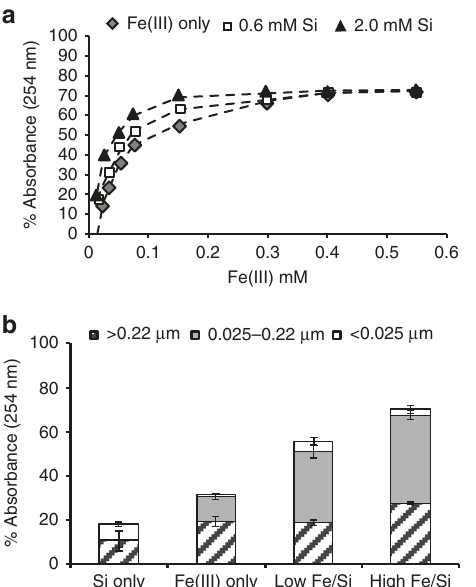
Fig. 4 UV-C attenuation in cell free, Fe(III) – Si-supplemented growth media. a Attenuation (% absorbance at 254 nm wavelengths) of UV-C radiation in un fi ltered, cell-free growth medium supplemented with varying amounts of Si and Fe(III) (diamond: Fe(III) only; square: 0.6 mM Si; triangle: 2.0 mM Si). b UV-C attenuation in solutions that have been sequentially fi ltered to separate dissolved (<0.025 μ m), nanoparticulate (0.025 – 0.22 μ m), and colloidal (>0.22 μ m) Fe(III) – Si fractions. Attenuation effects of the A + medium have been subtracted. Error bars (if not shown than smaller than symbols) represent standard deviation at 2 σ uncertainty